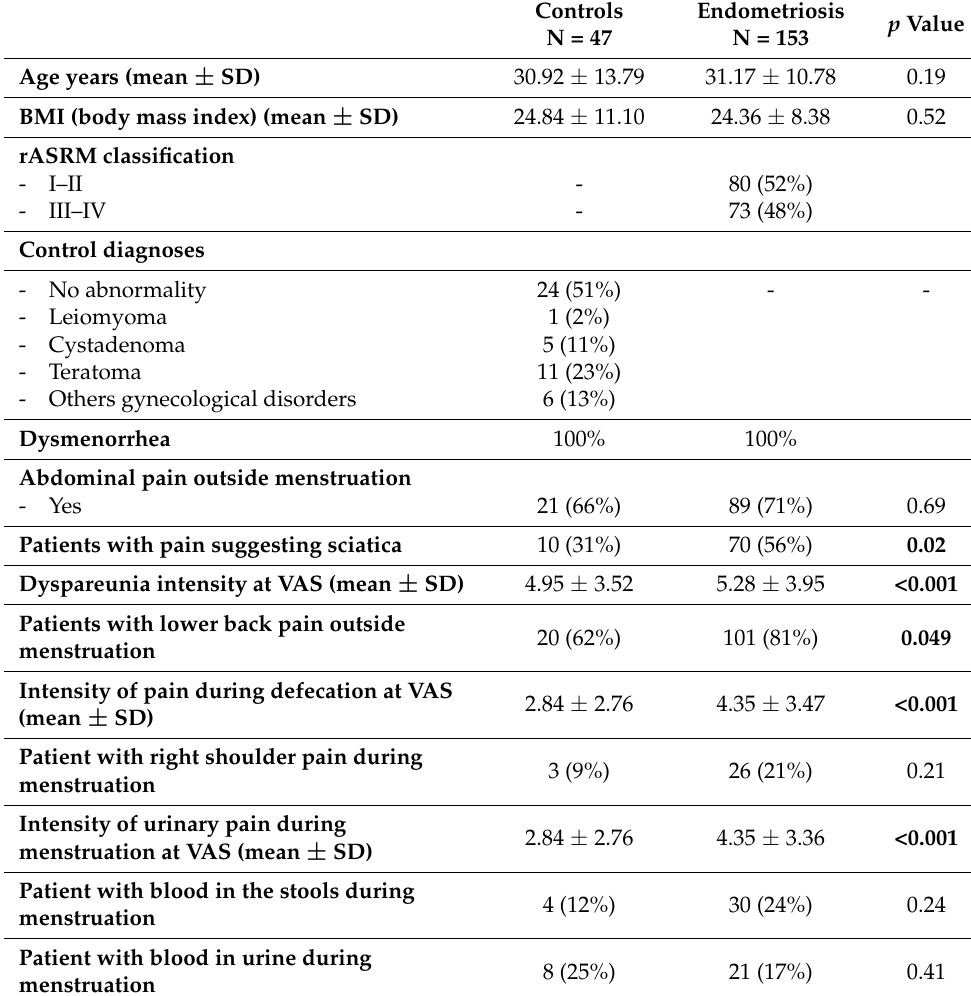
Table 1. Main characteristics of the patients